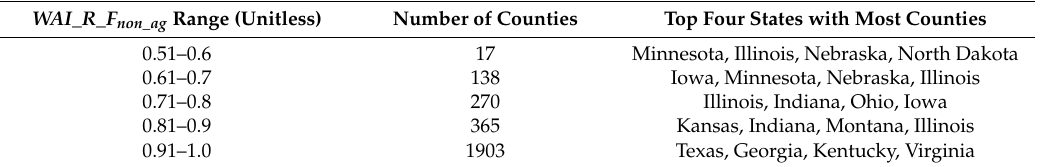
Table 5. Number of counties that fall within each WAI_R_F non_ag value (dimensionless fractions) band.